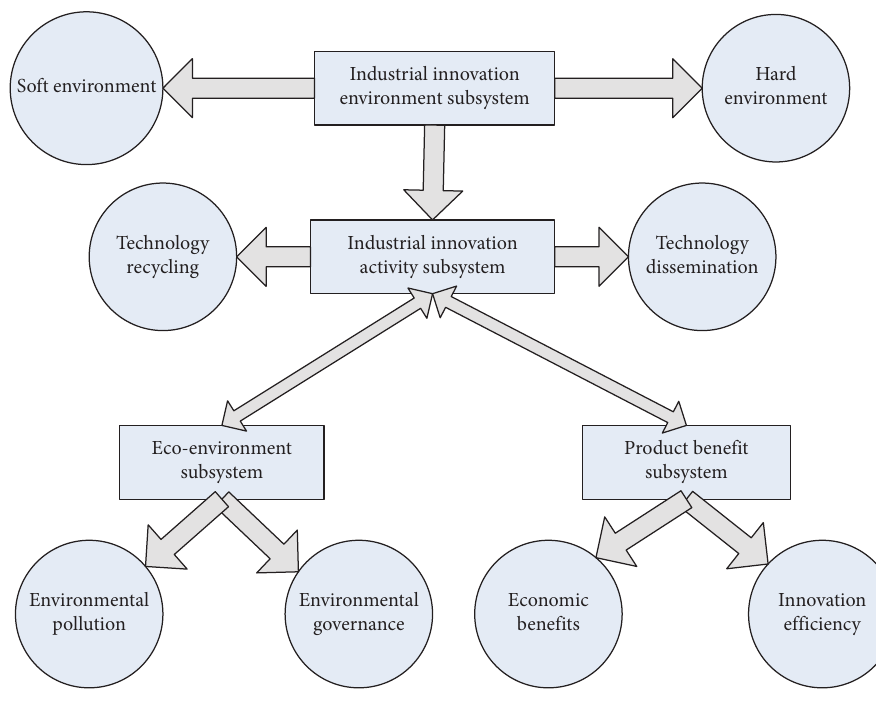
Figure 1: Principle of